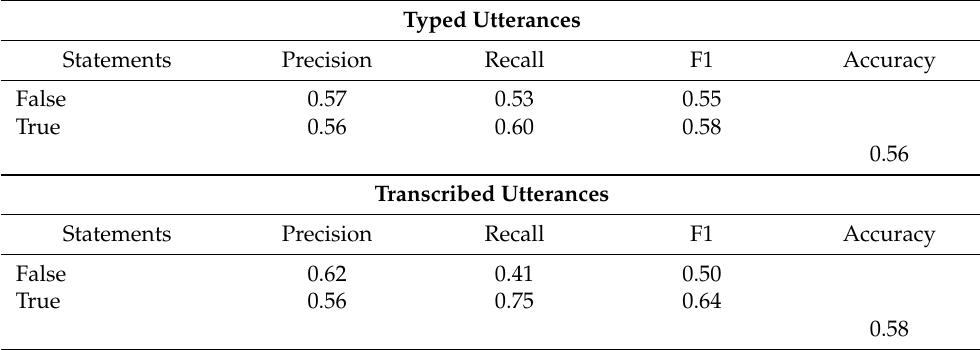
Table 5. Results of human